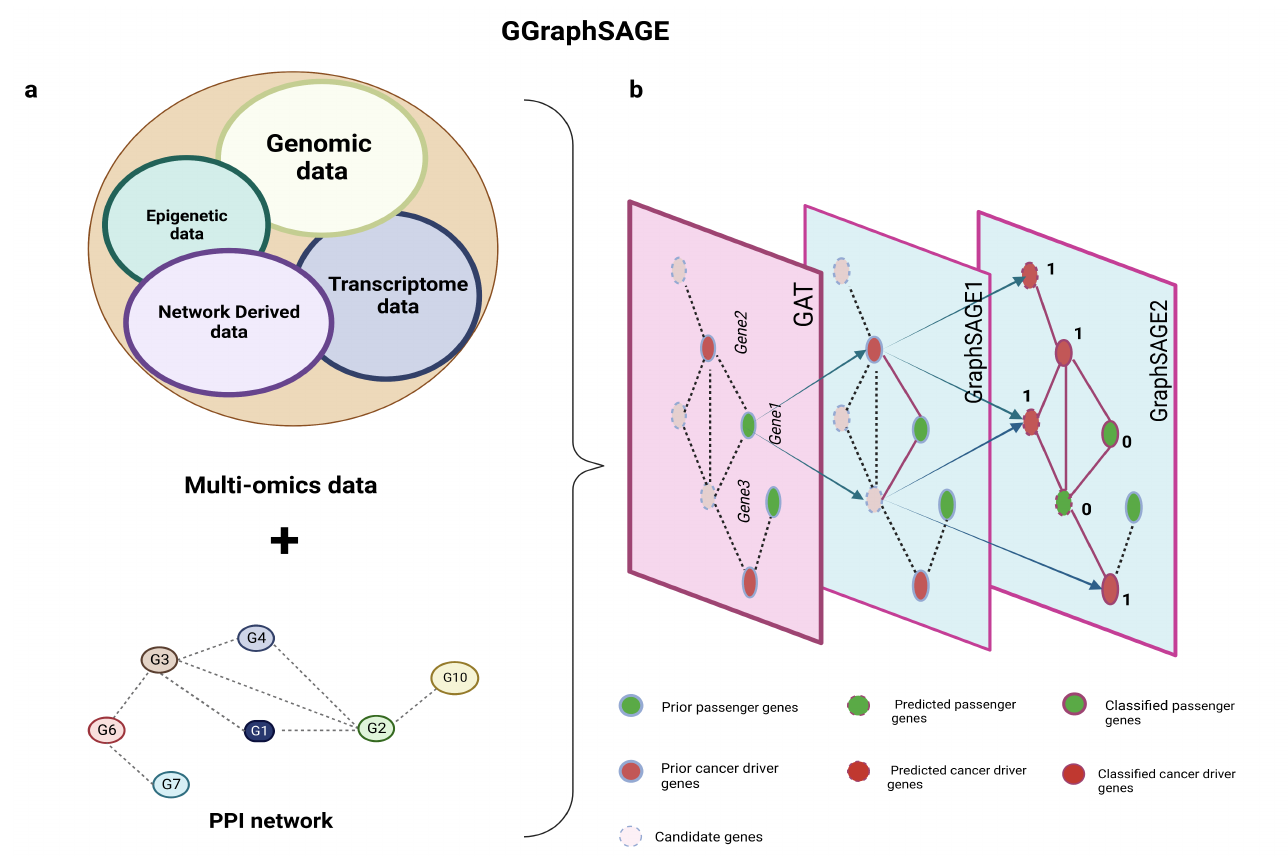
Figure 1. Schematic diagram of GGraphSAGE framework. ( a ) Inputs of GGraphSAGE framework include multiomics data (transcriptomic, genomic, and epigenetic data) and network and network- derived data; ( b ) all features and the PPI network are used for the semisupervised training of cancer driver genes. During the training of the GGraphSAGE model, the features are compressed by a three- layer graph aggregate operation and gradually include an increasingly wide range of neighboring nodes. The final output is determined by a probabilistic model (of whether it is a cancer driver